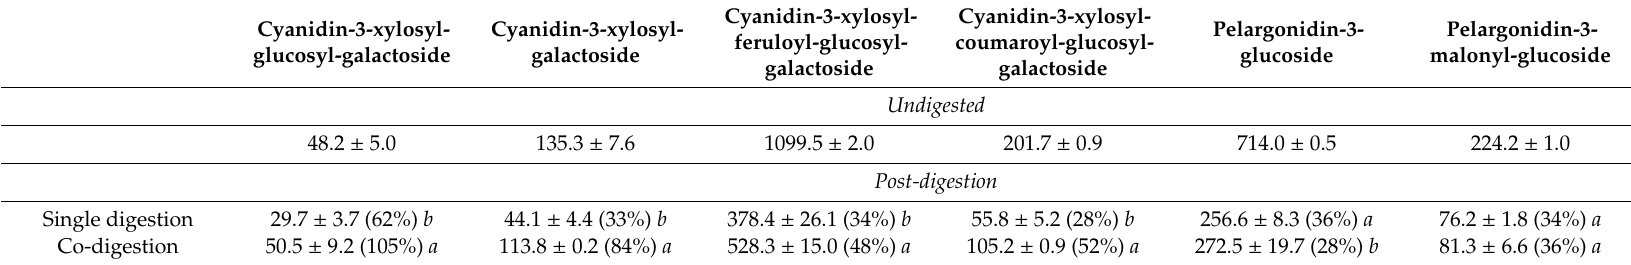
Table 3. E ff ect of co-digestion on black carrot and strawberry anthocyanins bioaccesibility, incubated as matrix-containing powder. Concentration expressed as mg / 100 g of sample (dry weight) (mean ± SD) ( n = 3). Values in brackets represents bioaccessibility